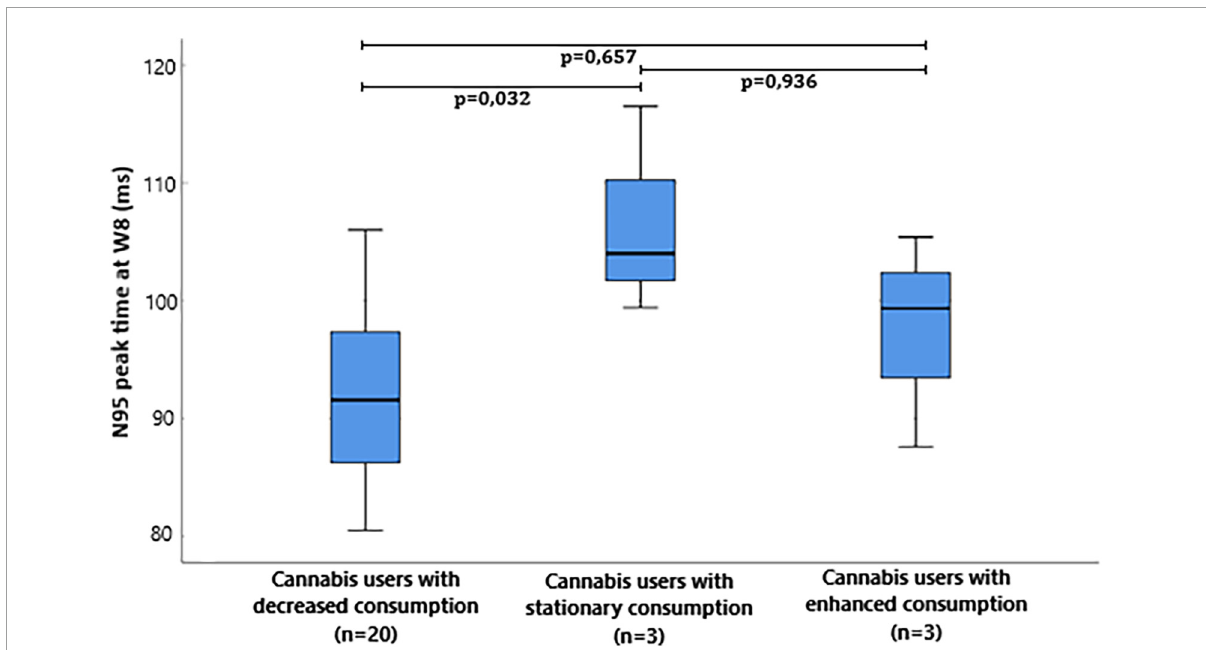
FIGURE1 Box plot of Pattern electroretinogram (ERG) N95 peak time milliseconds (ms) at W8 in cannabis users divided in groups depending on the evolution of consumption between W0 and W8.